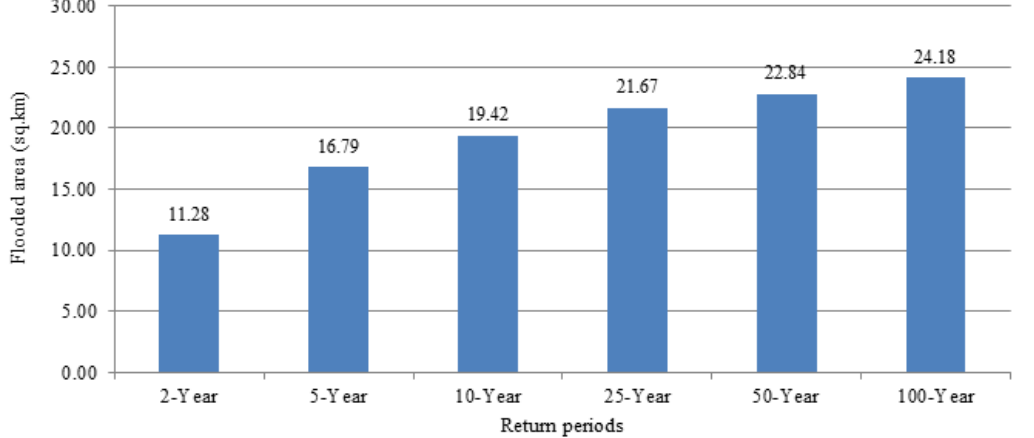
Fig. 10: Area flooded of Malingon River in different return periods